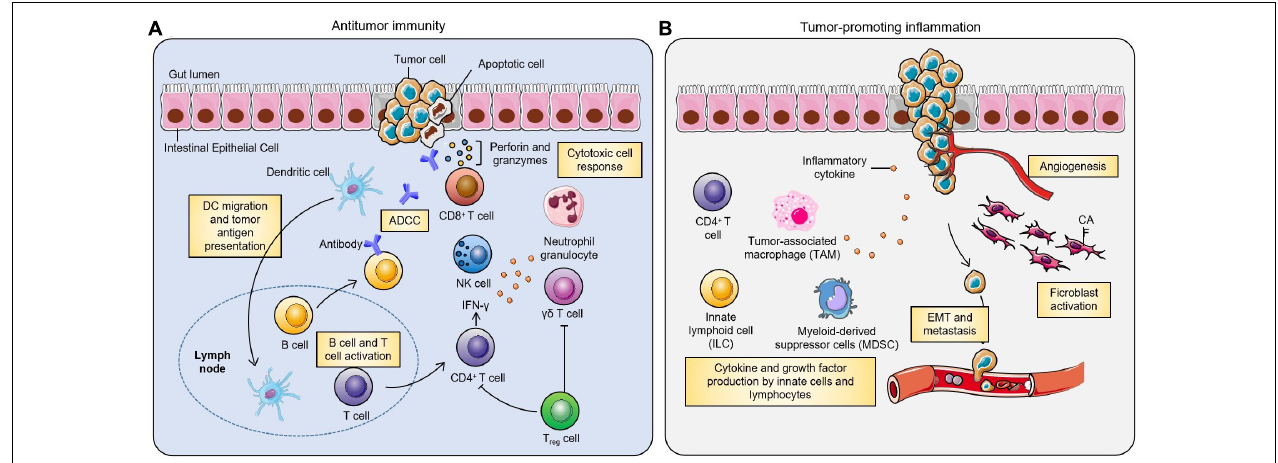
FIGURE 1 | Inflammation is a double-edged sword in development of colorectal cancer (West et al., 2015). Inflammation plays a critical role in the pathogenesis of CRC. (A) In anti-tumor immunity, dendritic cells can recognize and present tumor antigens and activate tumor-specific B cells and T cells. Traditionally, effective anti-tumor immunity is mainly mediated by CD4 + T cells, CD8 + T cells and natural killer cells (NK cells). There is growing evidence that γδ T cells are also involved in anti-tumor immunity, and that Treg cells can restrain this process. (B) In addition, inflammation can also promote tumor development. CD4 + T cells, innate lymphoid cells and tumor-associated macrophages in the tumor microenvironment can induce the production of a variety of inflammatory cytokines, which lead to tumor proliferation, invasion, angiogenesis, epithelial-mesenchymal transition and